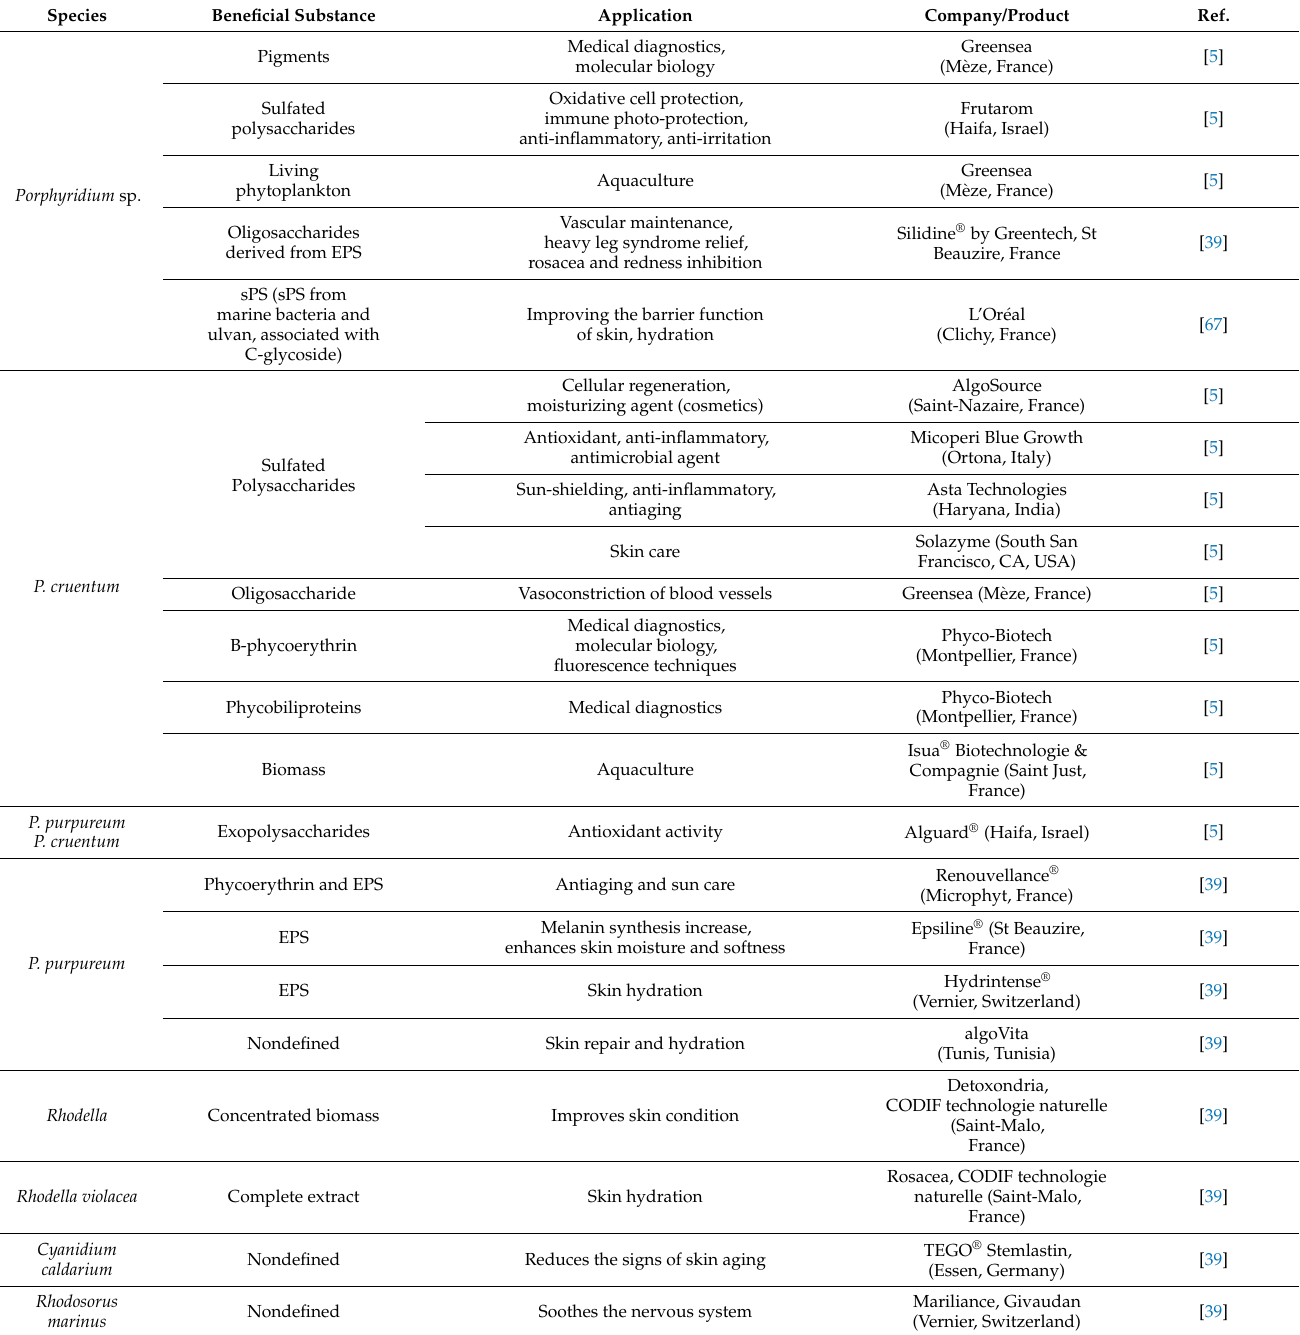
Table 2. Industrial application of bioactive compounds produced by red